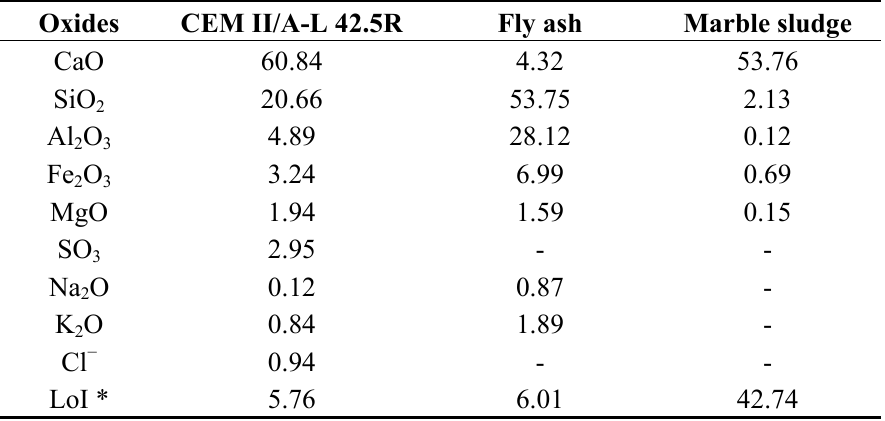
Table 2. Chemical composition of raw materials (wt%).